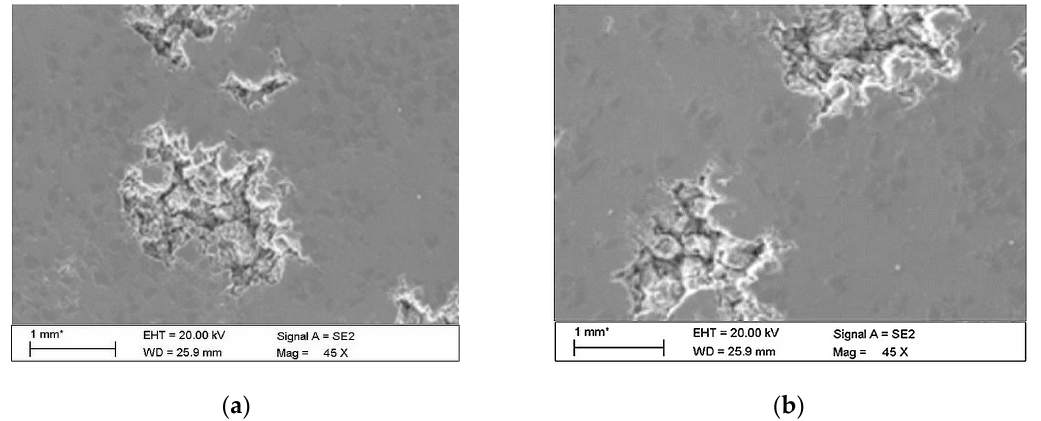
Figure 15. Surface of tested aluminium alloy after 7 ( a ) and 14 ( b ) days of testing in tap water. Visible changes in form of pits.